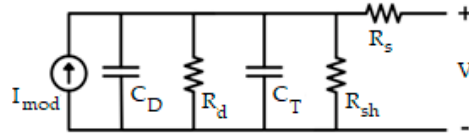
Figure 5. Equivalent dynamic electrical circuit for photovoltaic (PV) module ([44]).